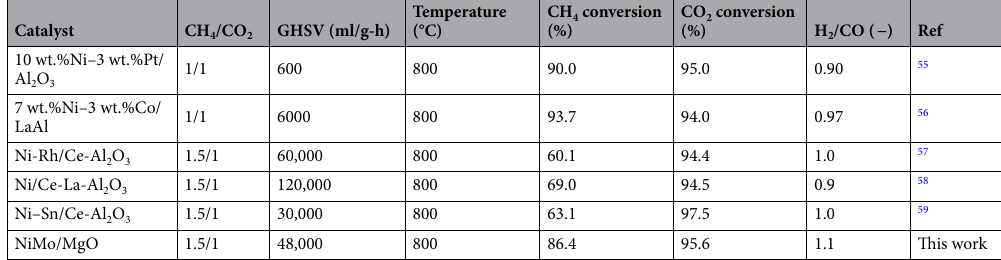
Table 4. Comparison of the catalytic performance of Ni-based catalysts in producing syngas from biogas.